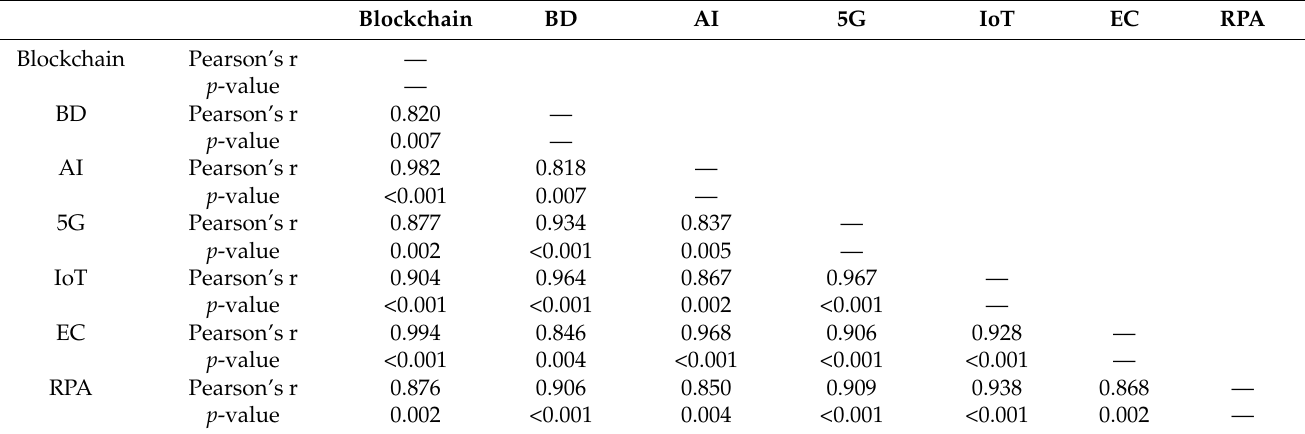
Table A1. Correlation